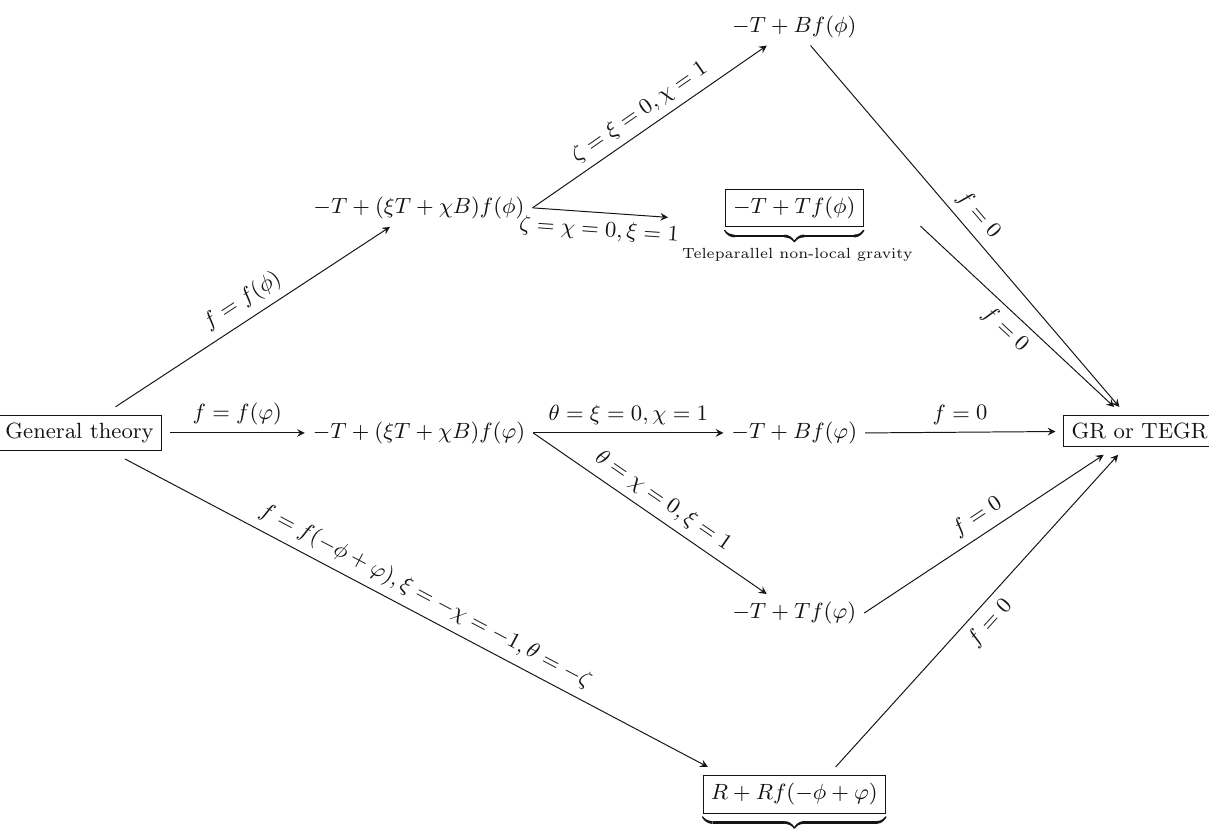
Clearly, the curvature and torsion representations “converge” only for the linear theories in R , the GR, and in T , the TEGR